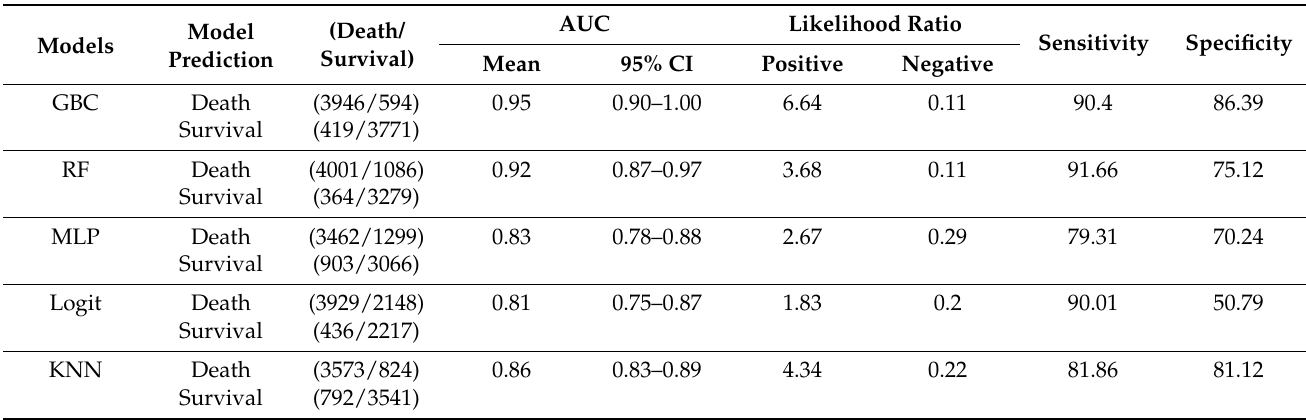
Table 3. The Discrimination Performance of Mortality Prediction Models with Rebalanced data using SMOTE.